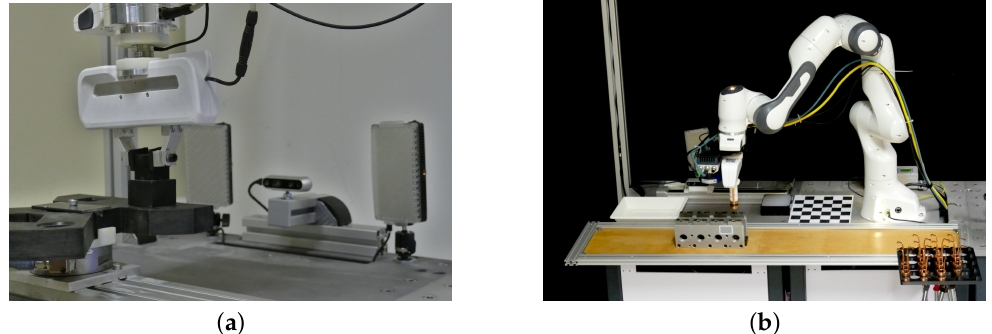
Figure 3. Experimental setup for testing exception strategy learning using multimodal data. ( a ) Setup for the Cranfield benchmark . ( b ) Setup for the copper ring insertion